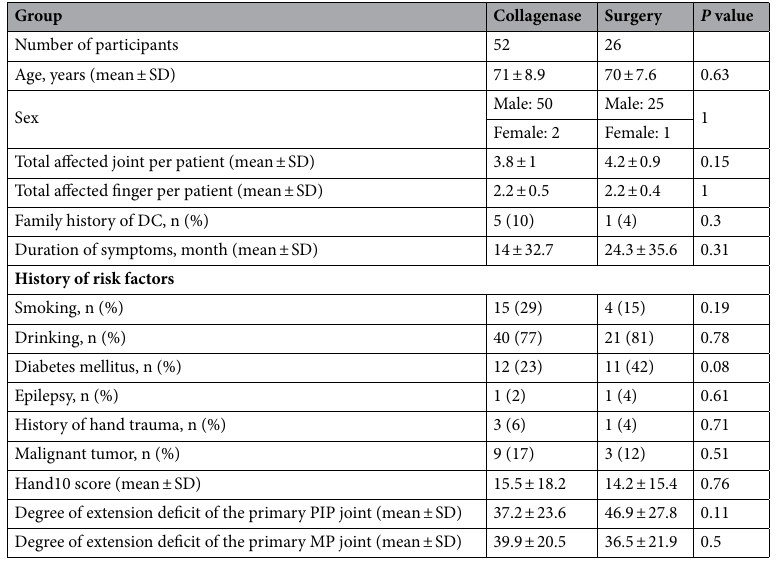
Table 1. Demographic and baseline clinical characteristics of participants. DC Dupuytren’s contracture, MP metacarpophalangeal, PIP proximal interphalangeal, SD standard deviation, n number.